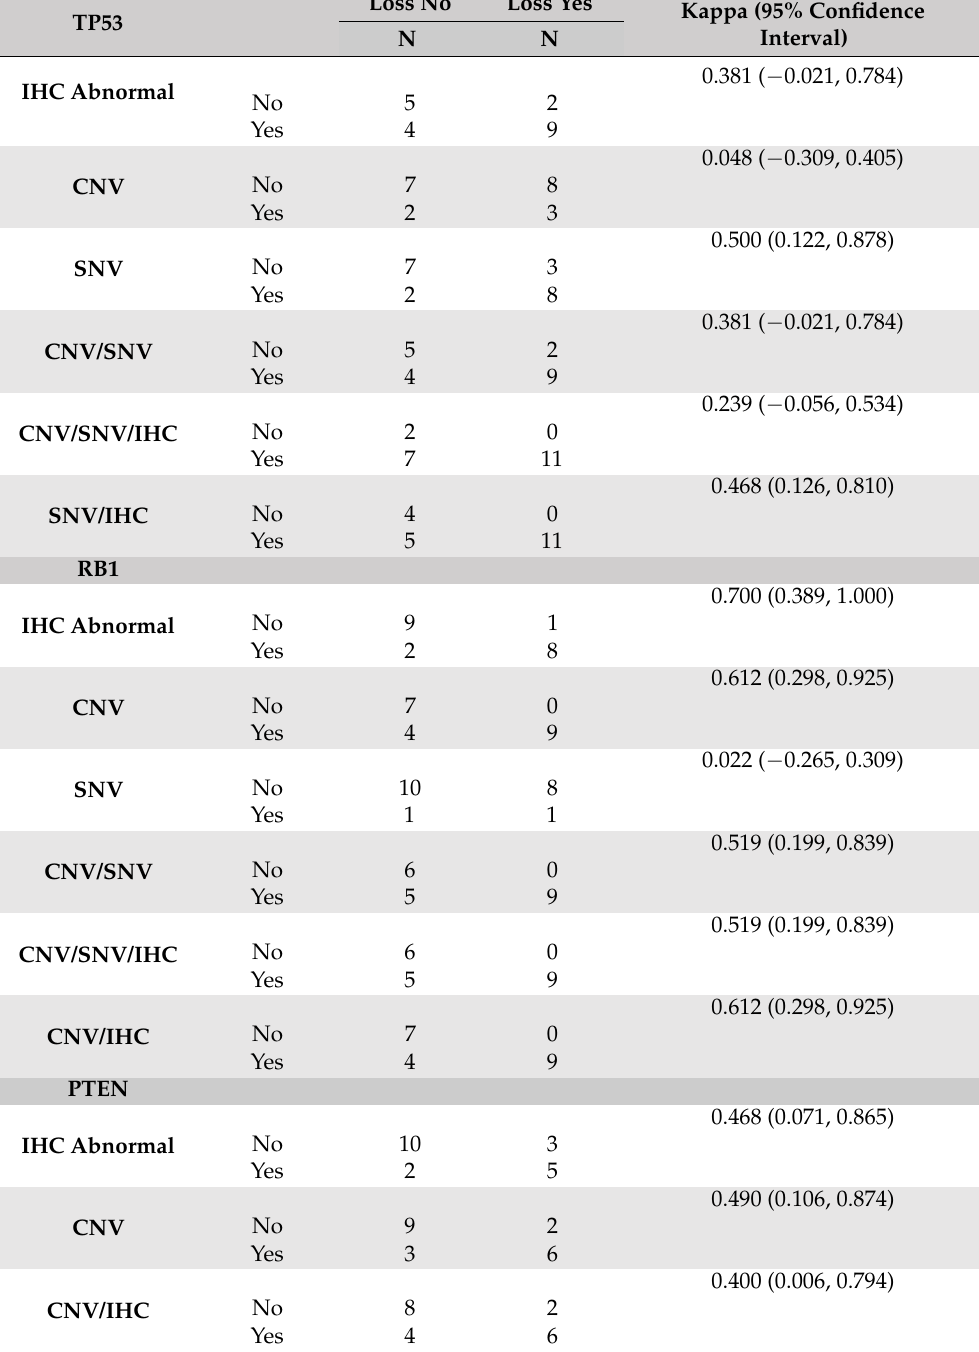
Table 1. Associations of immunohistochemical (IHC) and genetic measures of determining TSP aber- rations with functional tumor suppressor pathway loss among 20 patient tumor-derived xenografts of human prostate cancer. Comparisons were made between IHC, copy number variations (CNV), single nucleotide variations (SNV) and combinations of the three, in terms of their ability to determine abnormal tumor suppressor function (true positives). Shown are the Cohen’s kappa measure of inter-method agreement with the 95% confidence